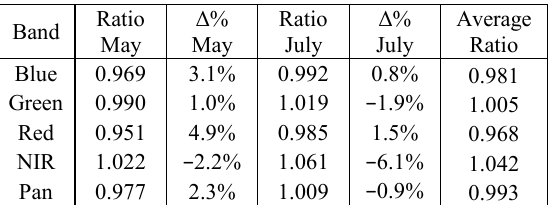
Table 3. Proposed calibration results for May and July 2019 for SSOT.